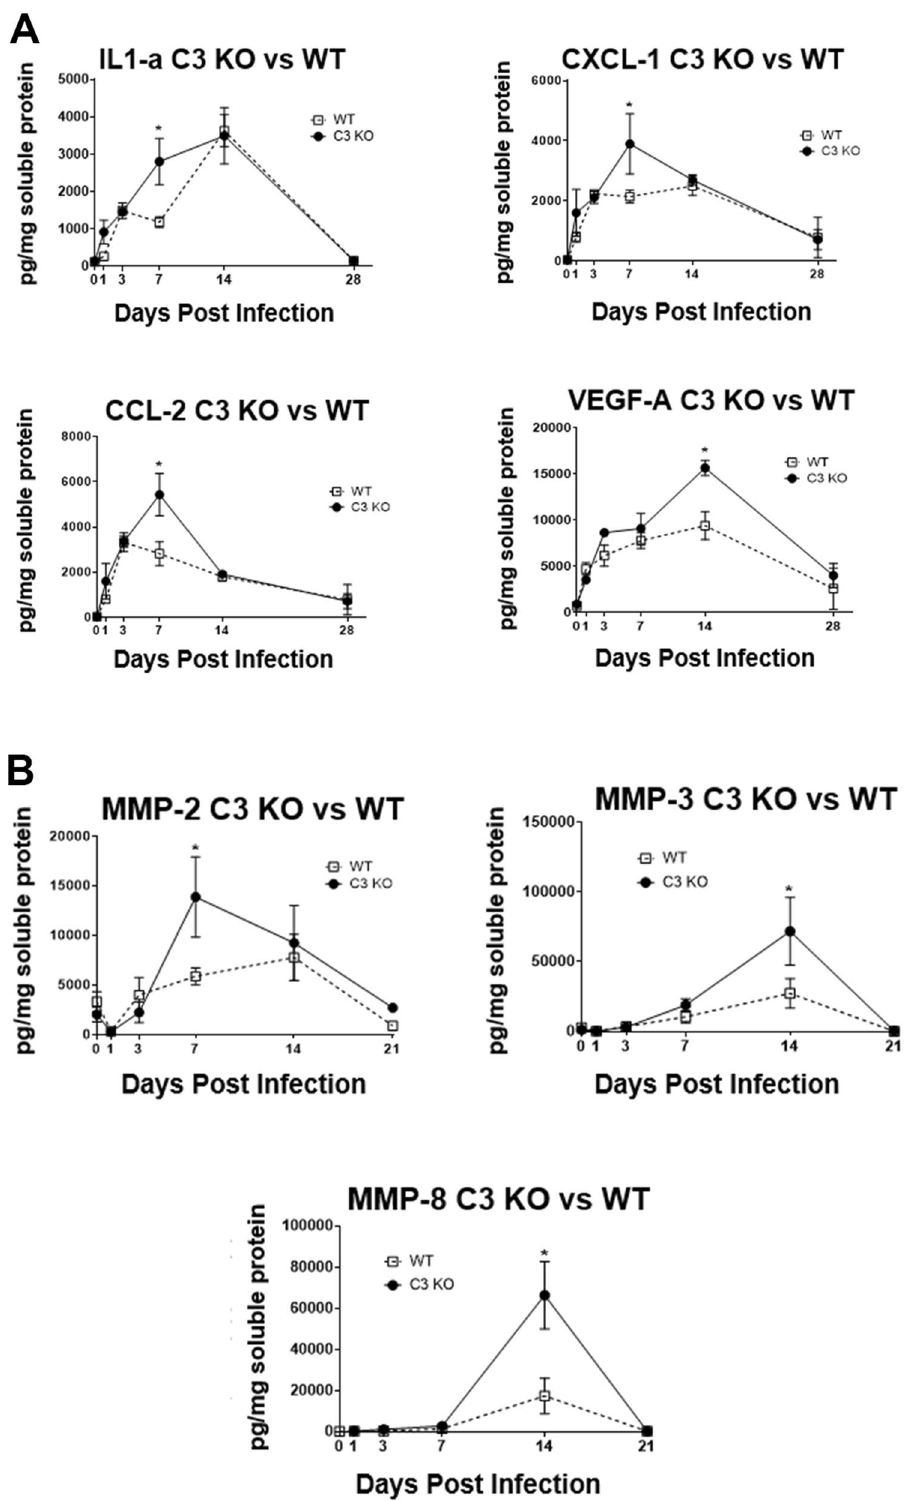
Figure 3. The absence of C3 temporally enhances MMP and cytokine/chemokine expression in the cornea. HSV-1 infected WT and C3 KO mice (n = 6/group/time point) were euthanized by exsanguination at the indicated time pi. The corneas were removed and processed for analyte assessment by multiplex suspension array. ( A ) Levels of IL-1α, CXCL1, CCL2, and VEGF-A and ( B ) MMP-2, MMP-3, and MMP-8 are shown for the indicated time points. Each time point is displayed as the mean pg/mg protein ± SEM representing the summary of two experiments. * p < 0.05 comparing the two groups for the indicated time point as determined by unpaired t -test with Holm–Sidak